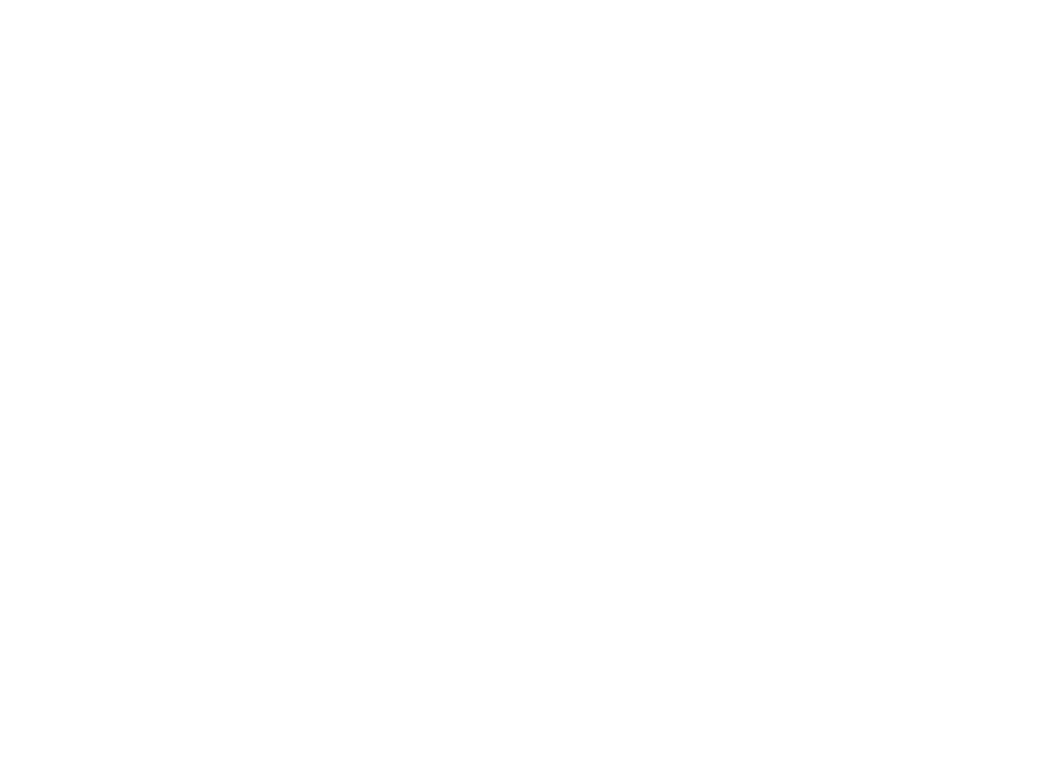
Figure 6. ( a ) Optimal biogas production (mL) as a function of hydraulic retention time, ( b ) optimal methane content (%) as a function of hydraulic retention time, ( c ) methane content (mL) as a function of hydraulic retention time at 35